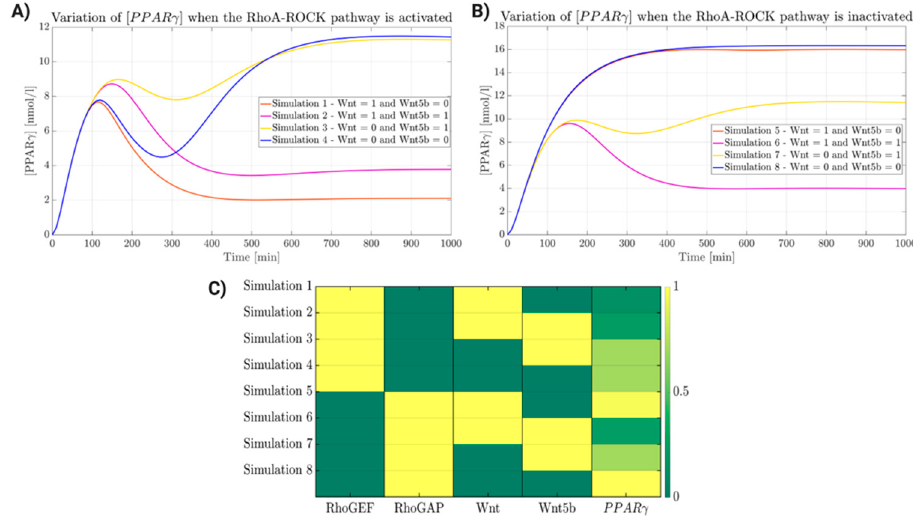
Figure 6. PPAR γ variations in response to activation/inactivation of Wnt/ β -catenin and RhoA-ROCK pathways. Orange, purple, yellow and blue curves are obtained by varying the concentrations of Wnt and Wnt5b. Panels ( A , B ) show activation (high concentration of Rho-GEF, 100 nM, and low concentration of Rho-GAP = 0) and inactivation (high concentration of Rho-GAP, 100 nM, and low concentration of Rho-GEF = 0) of RhoA-ROCK pathway, respectively. ( C ) ColorMap summarizes the effects of the eight simulated experimental conditions on the steady-state concentration of PPAR γ . Each column is normalized with respect to its maximum value.